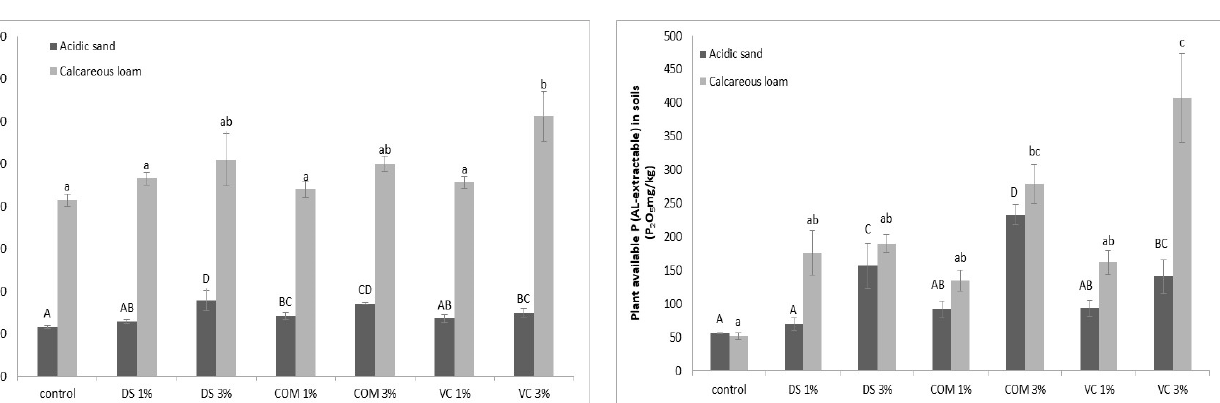
Figure 3. Changes in the concentration of total and plant-available P in the soil 75 days after the application of digested sludge (DS), digested sludge compost (COM), and digested sludge vermicompost (VC) in 1% and 3% doses. Error bars represent the standard deviation (SD) of the mean with 3 replicates. Uppercase letters indicate significant differences between treatments on acidic sand and lowercase letters indicate significant differences between treatments on calcareous loam ( p < 0.05).